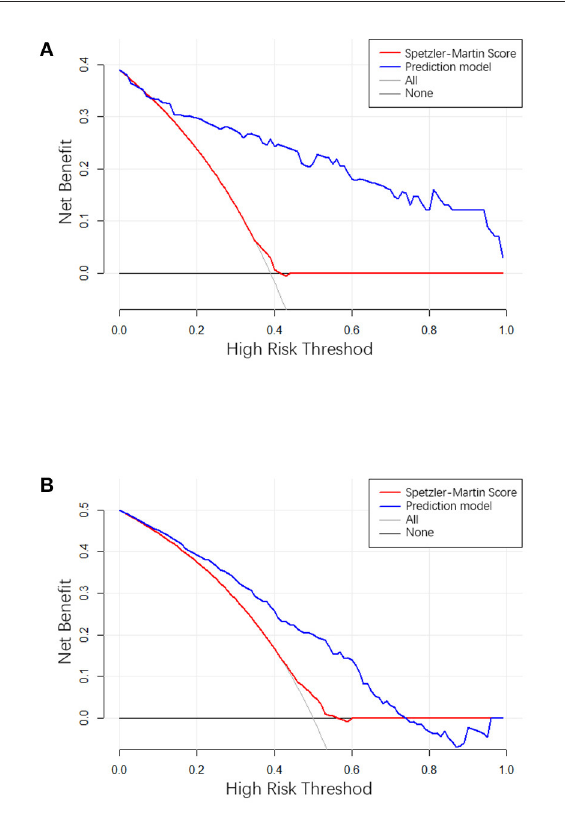
FIGURE5 (A) The result of decision curve analysis in the training cohort. (B) The result of decision curve analysis in the validation cohort. The X-axis is the high-hemorrhage risk threshold, and Y-axis is the net benefit. The red line represents the prediction model. The net benefit is calculated by subtracting the proportion of all patients who are false positive from the proportion who are true positive, weighted by the relative harm of forgoing treatment compared with the negative consequences of an unnecessary treatment. The oblique line in the figure represents the net benefit when all the patients are treated as having hemorrhage, and gray horizontal line represents the net benefit when all the patients are treated as belonging to the non-hemorrhage